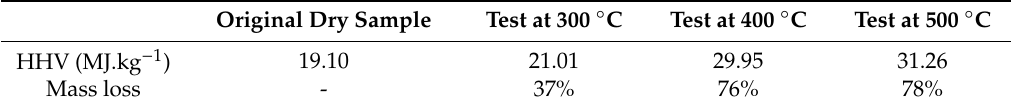
Table 4. High Heating Value (HHV) calculated for the di ff erent process